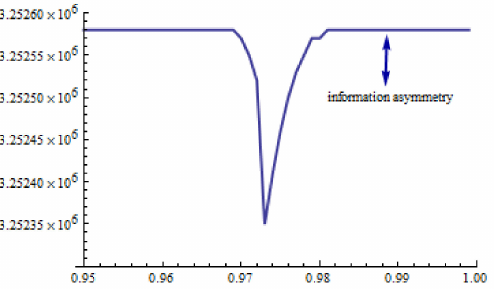
Figure 7. Trend chart of the expected revenue of the